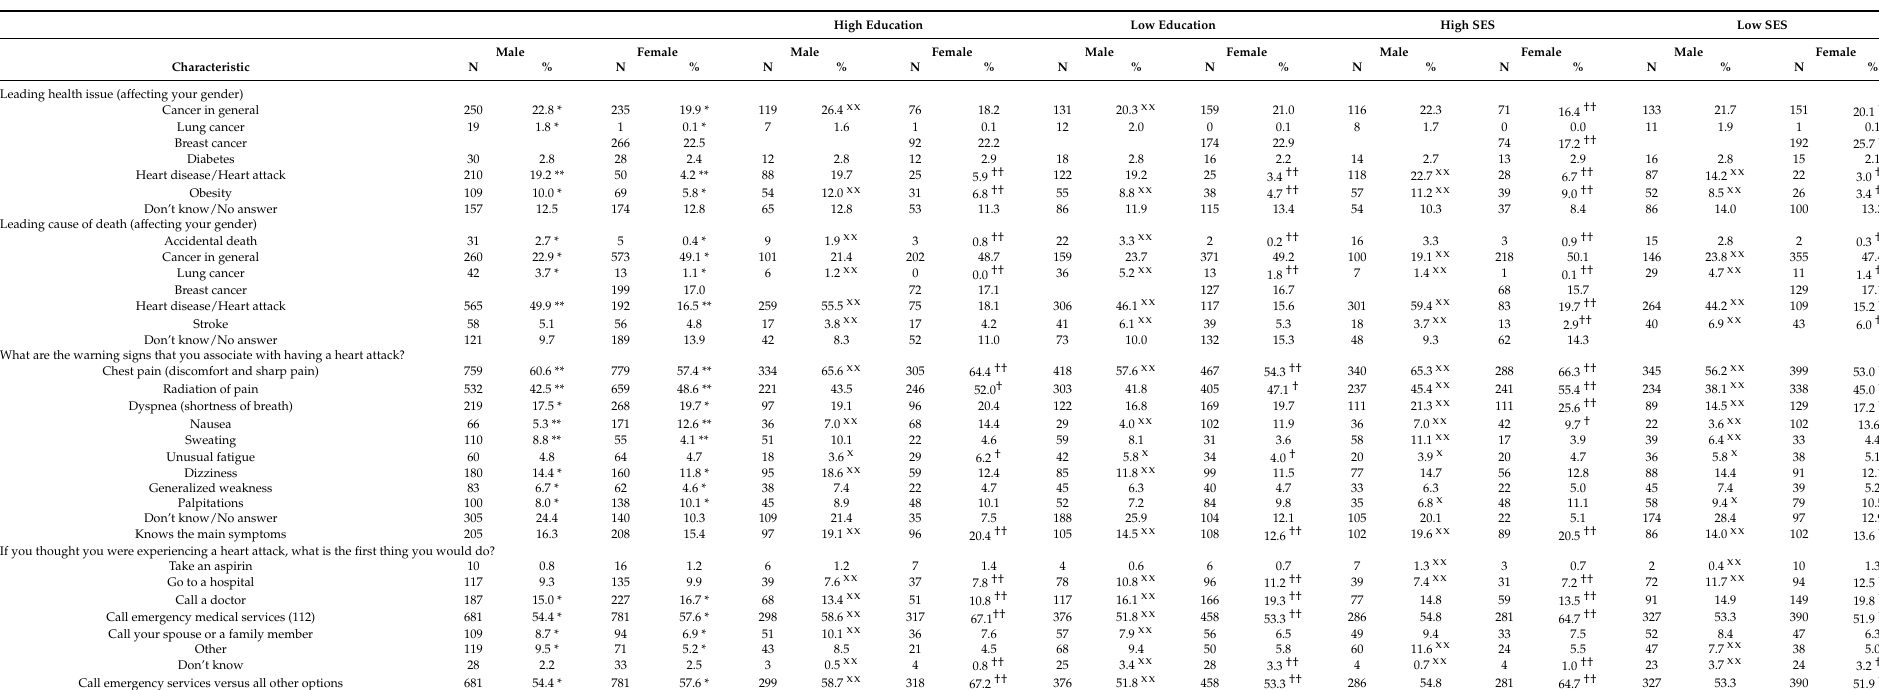
Table 2. Awareness of selected leading health issues, warning signs of a heart attack and responses to signs of a heart attack, according to gender, education and